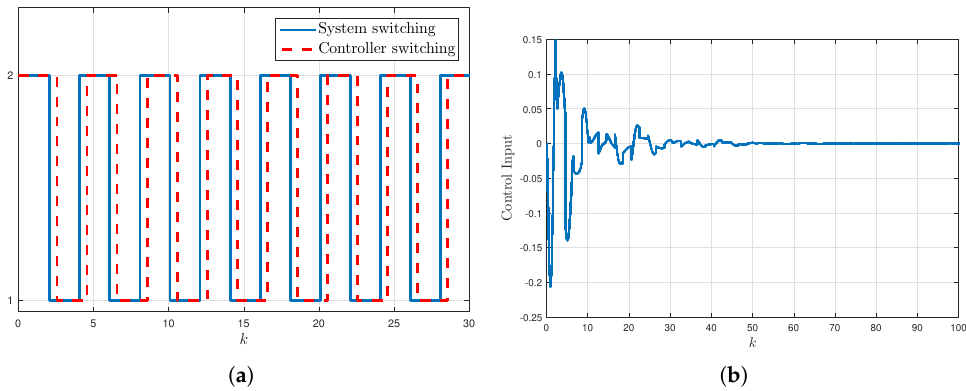
Figure 7. Switching signal and control input. ( a ) System and controller switching signal; ( b ) control input trajectory.